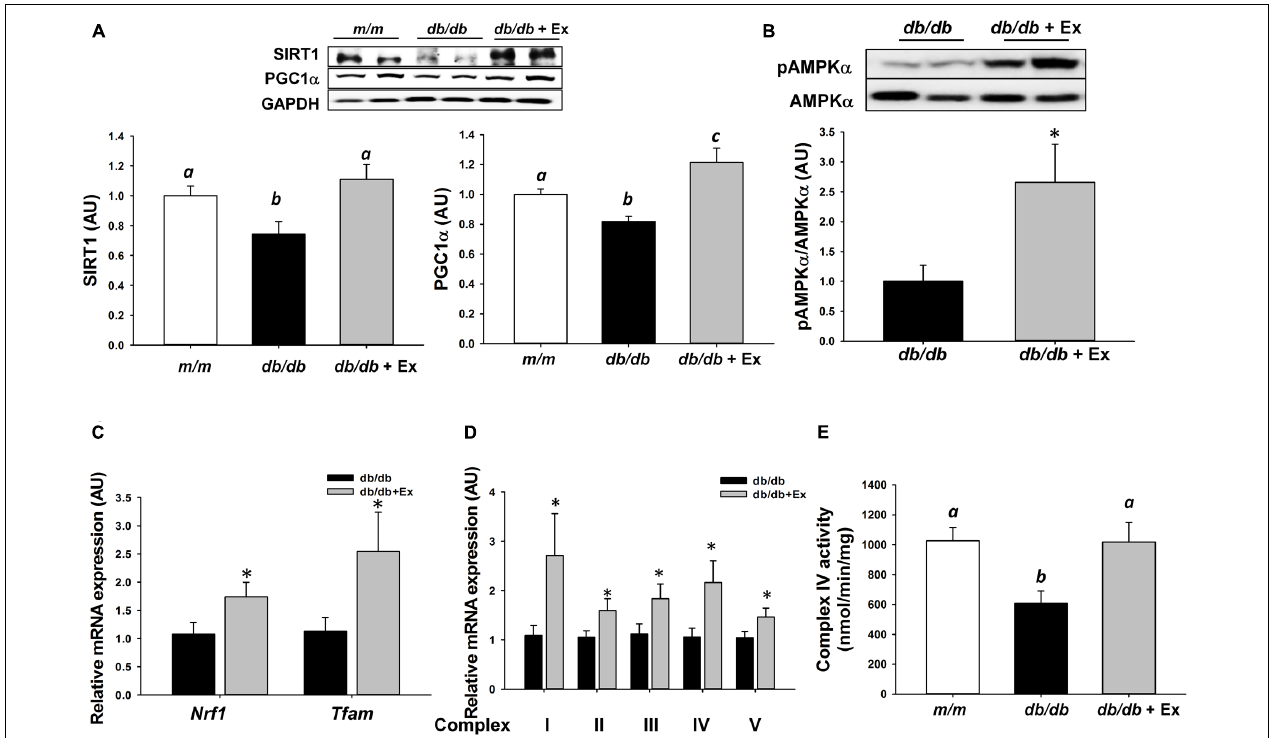
FIGURE 4 | Effect of moderate exercise training on protein expression, mRNA expression, and complex IV activity. Representative blots of SIRT1, PGC1 α , AMPK α , and phospho-AMPK α (Thr172) are shown (A,B) . The protein levels in gastrocnemius muscles are presented mean ± SEM ( n = 5–7/group). Nrf1, Tfam, and mitochondrial complexes I–V mRNA expression levels in gastrocnemius muscles are expressed as mean ratio to control after normalization with 18S mRNA levels. Fold differences were calculated using the (cid:49)(cid:49) C t method. Values presented are mean ± SEM ( C,D , n = 6–8/group, each in triplicate). Cytochrome oxidase (Complex IV) activity in gastrocnemius muscle ( E , n = 6/group). Significance ( P < 0.05) among groups is denoted by different letters. ∗ P < 0.05 vs. db/db